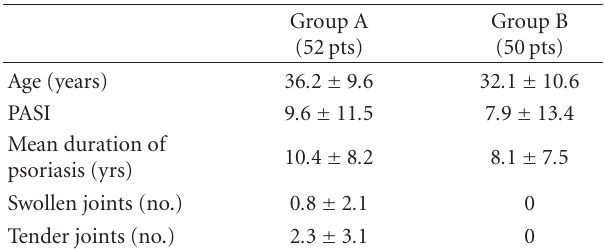
Table 1: Clinical characteristics of the study population (mean ±